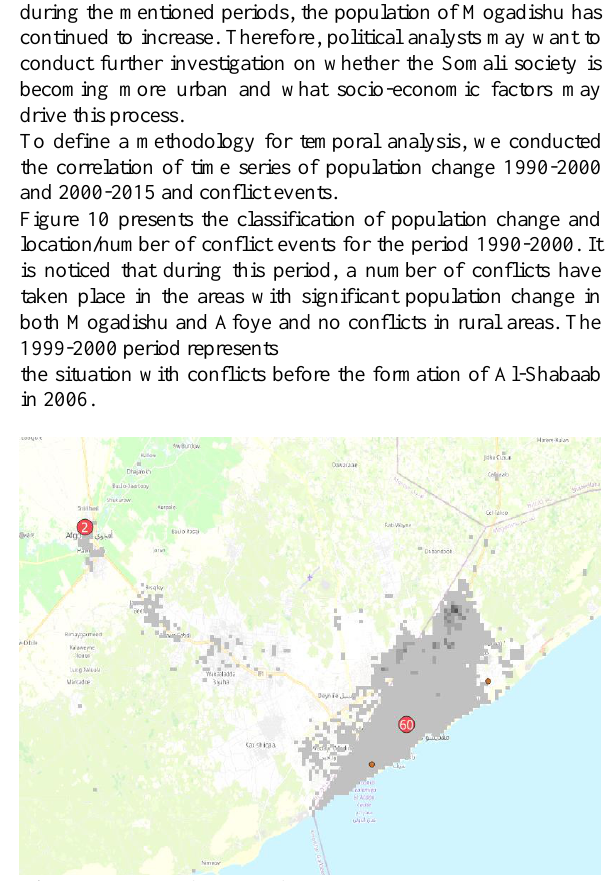
Figure 10. Classification of population change in Mogadishu for the period 1990-2000, and locations and number of conflict incidents for the same period.